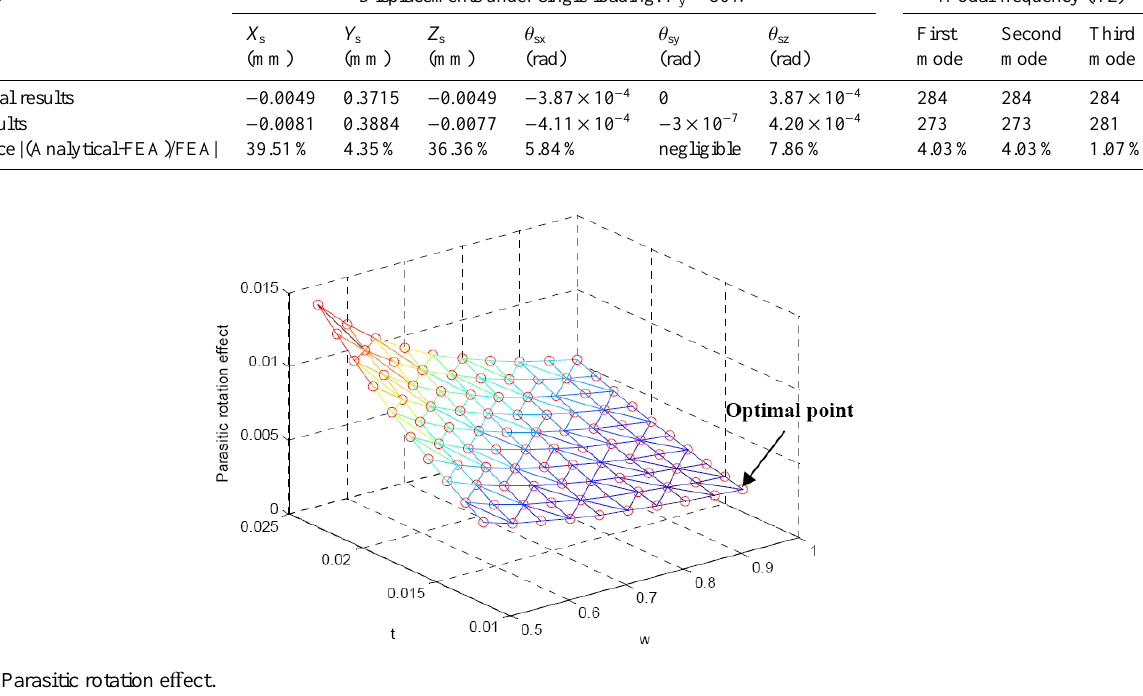
Figure 6. Parasitic rotation e ff